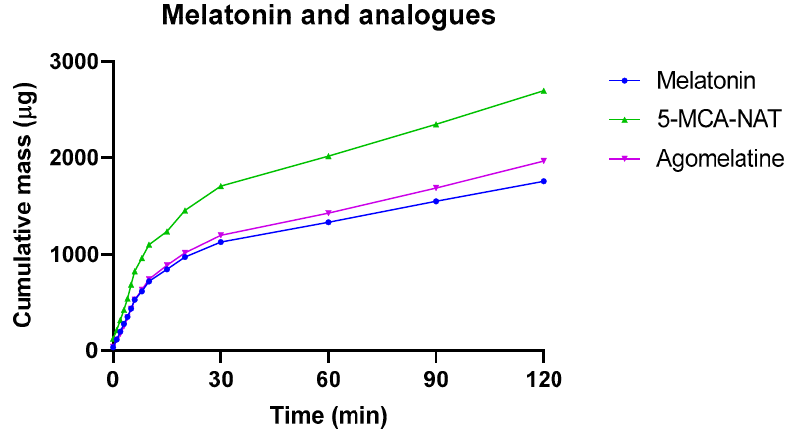
Figure 2. Soak and release method used with melatonin and analogues. There is a substantial release of drugs during the first 30 min and lasting for 2 h. (Balafilcon A. Silicon Hidrogel ionic).